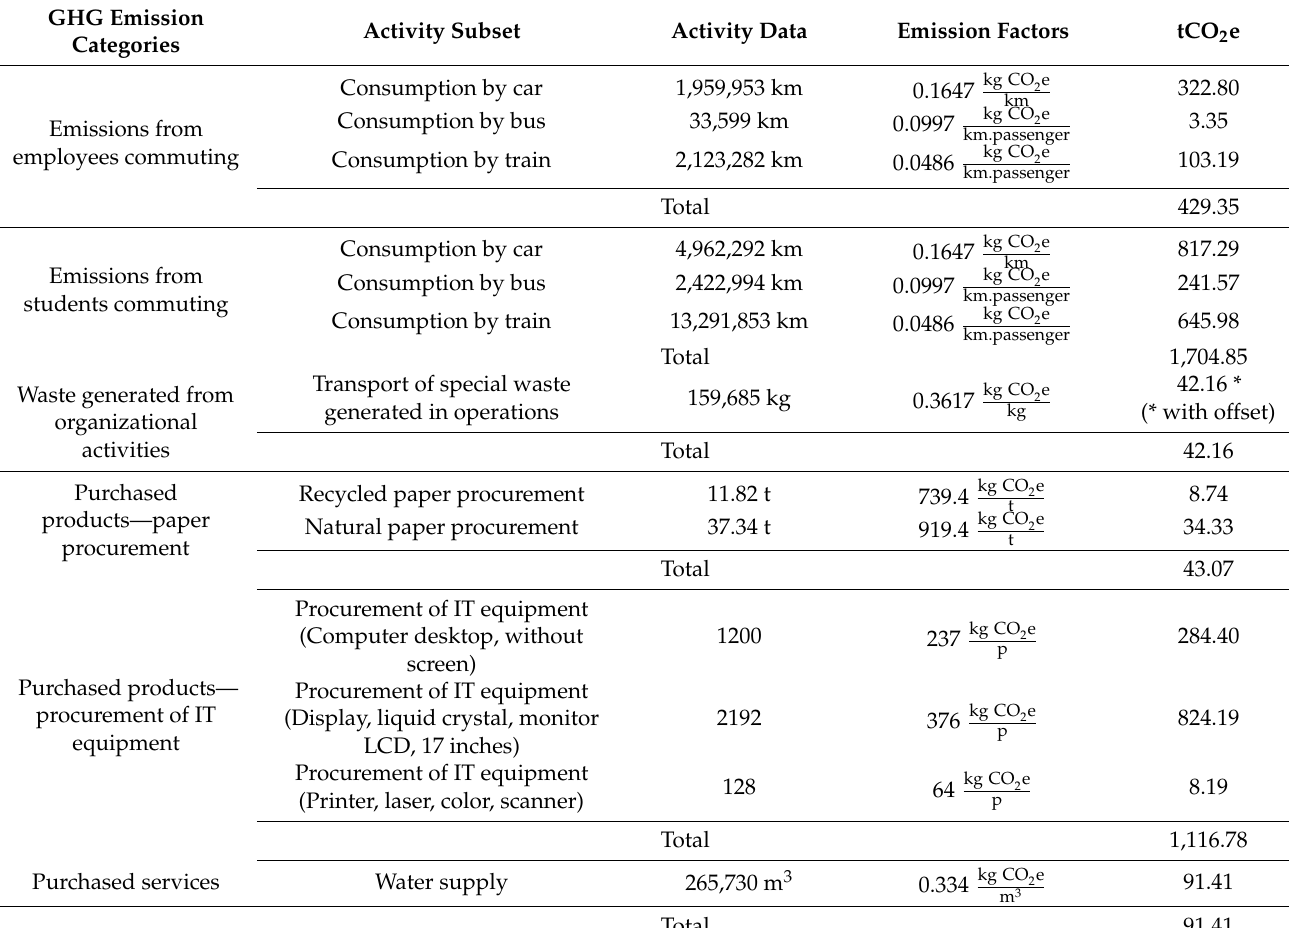
Table 6. Emissions from GHG categories of Scope